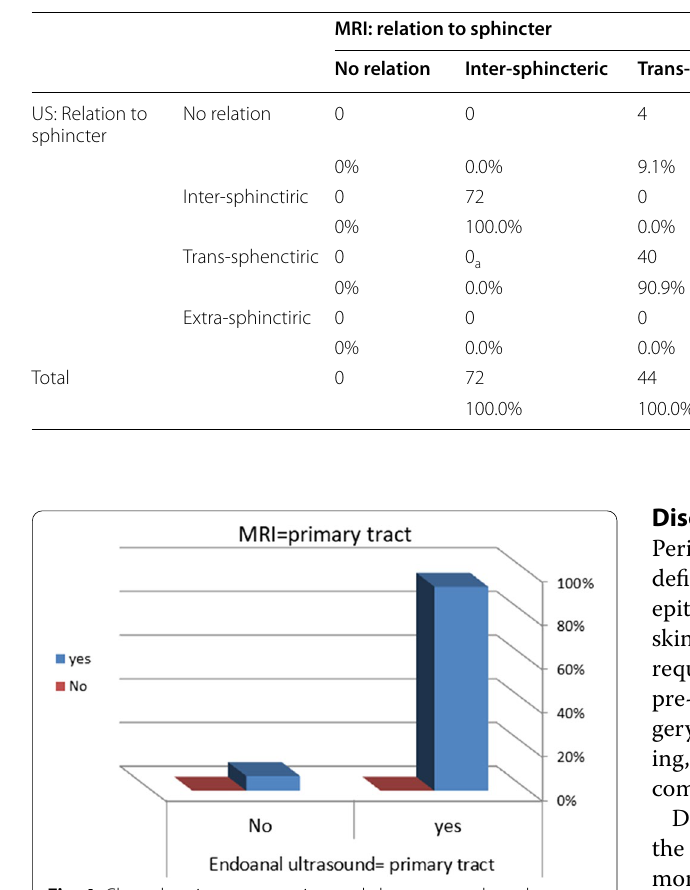
Fig. 4 Chart showing comparative study between endoanal ultrasound and MRI in the detection of the primary tract